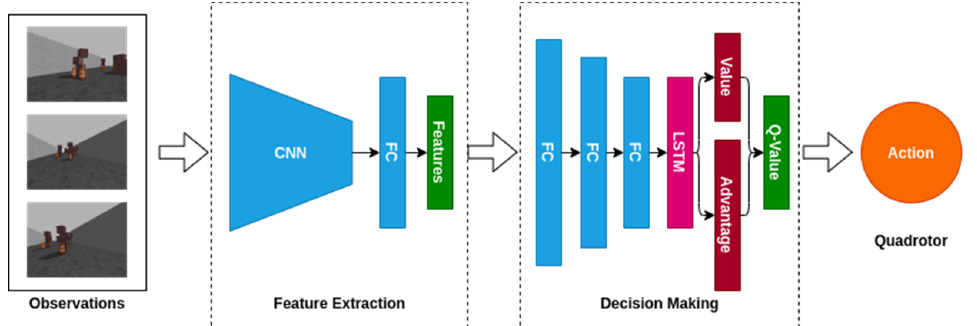
Figure 5. The architecture of the proposed framework.